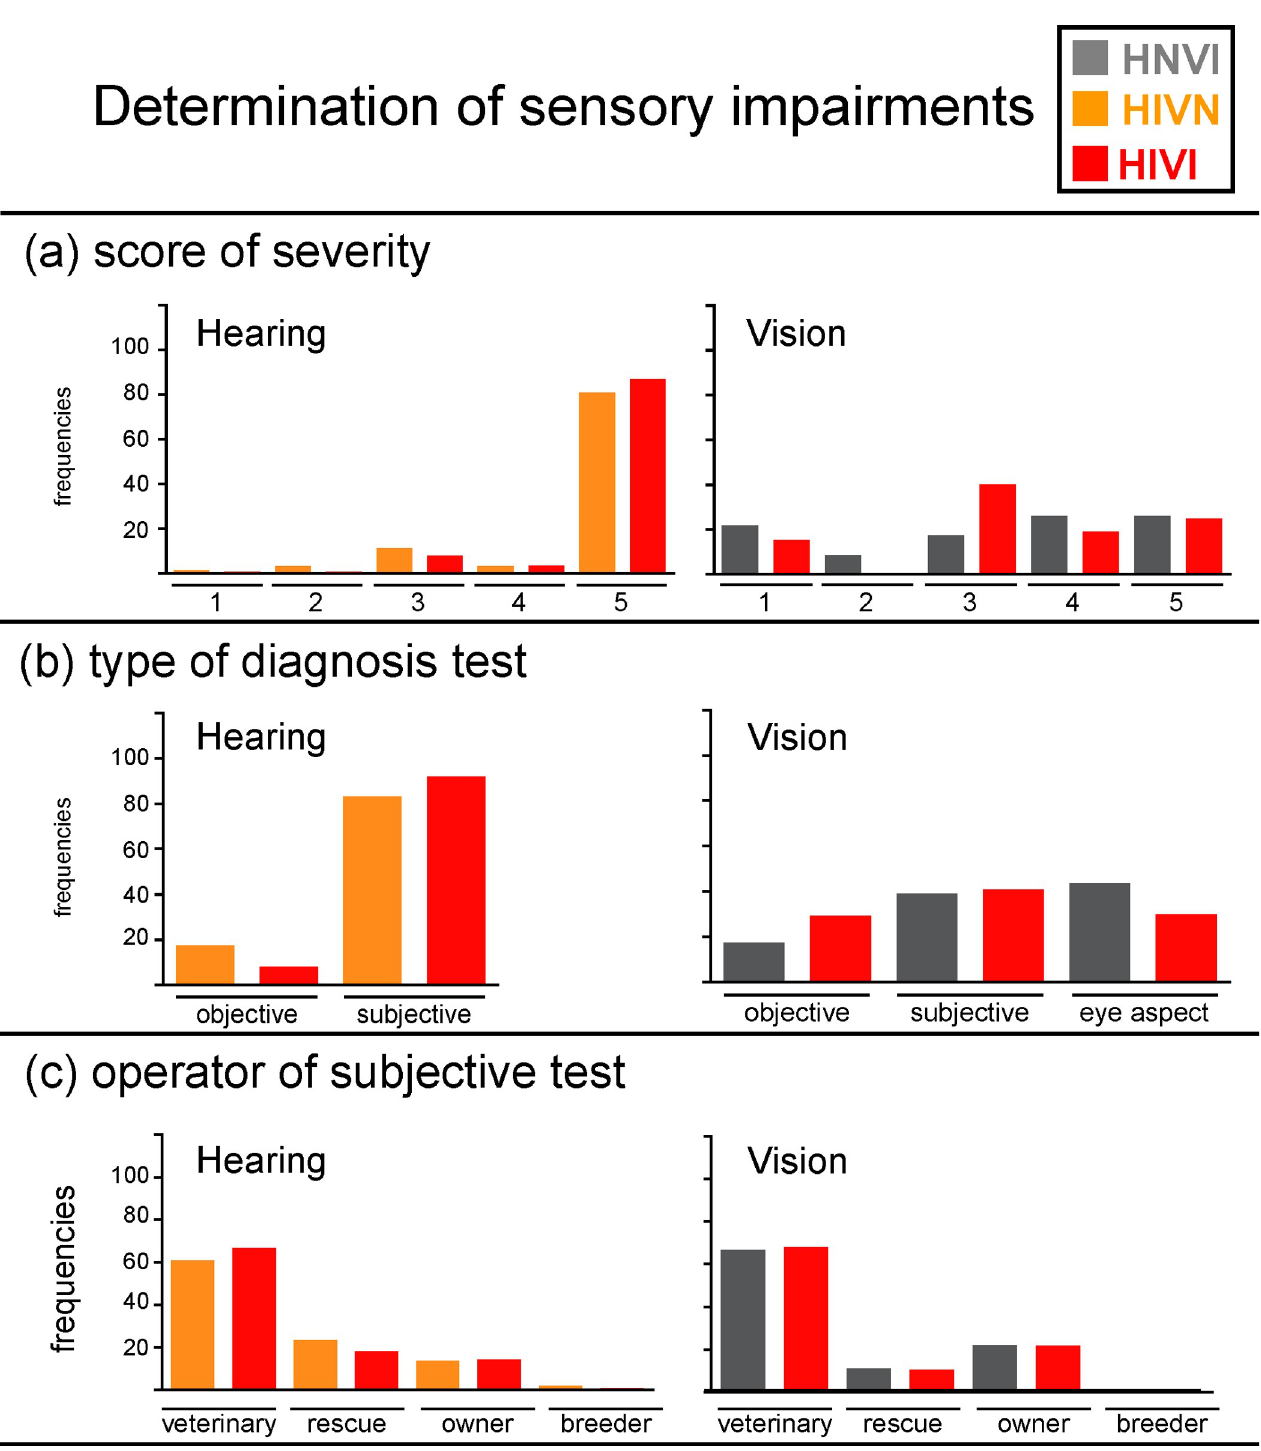
Fig 2. Frequencies of responses, in percentages, obtained for hearing impaired groups (left panels) and for vision impaired groups (right panels) for the following data: (a) score of severity of the impairment, (b) type of diagnosis test, and (c) operator of the subjective test. HNVI = hearing normal vision impaired (grey), HIVN = hearing impaired vision normal (orange), HIVI = hearing impaired vision impaired (red).